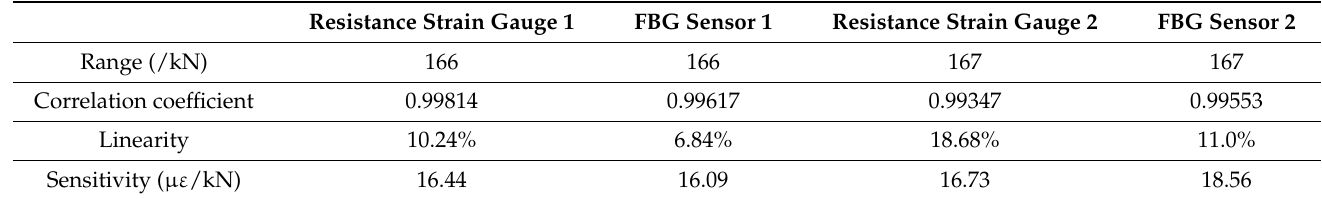
Table 2. A comparison of the indicators in the three groups of